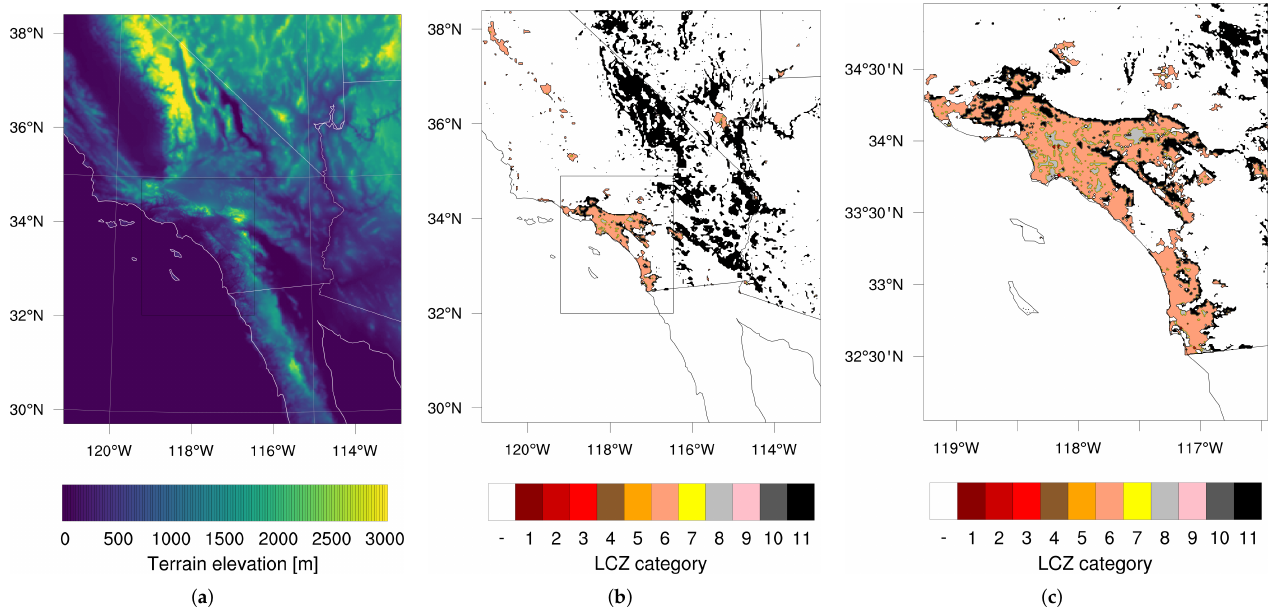
Figure 1. Domains of the simulations as well as a map of the terrain elevation ( a ) and LCZ land use type ( b , c ). The black rectangle in ( b ) shows the boundary of domain 2, which is displayed in ( c